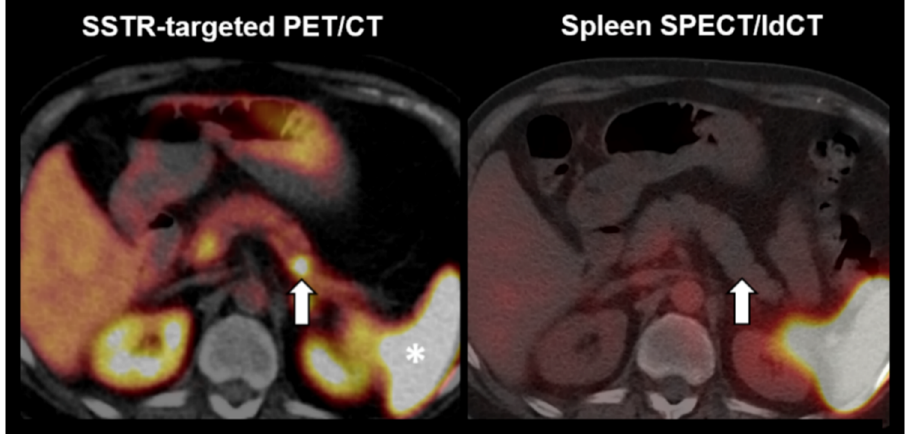
Figure 5. Example of a negative reading in spleen scintigraphy. ( Left ) Somatostatin receptor (SSTR)- targeted PET/CT. ( Right ) 99m Tc-labelled denatured red blood cells SPECT fused to low dose CT. Arrows = the suspected lesion. Asterisk = physiologic SSTR radioligand uptake in the spleen.